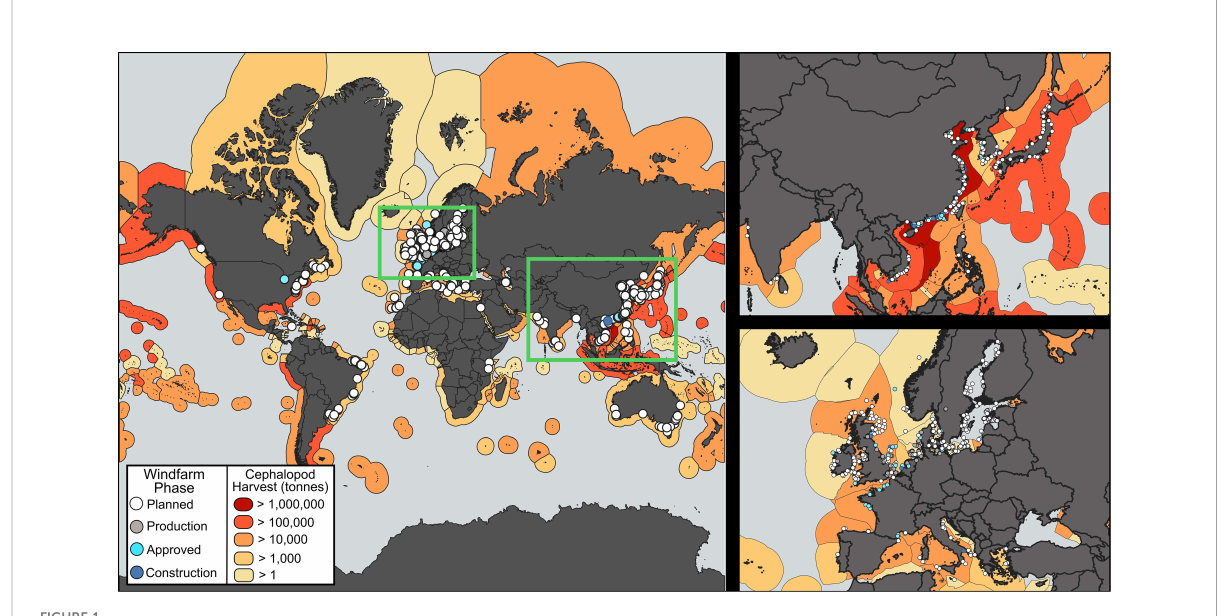
FIGURE 1 Future offshore windfarm construction largely overlaps with areas of high cephalopods harvest. The global map depicts individual OSW projects (dots) at four stages of development as well as the extend of cephalopod harvest within a country ’ s ocean governance area (The Wind Power (www.thewindpower.net), Food and Agriculture